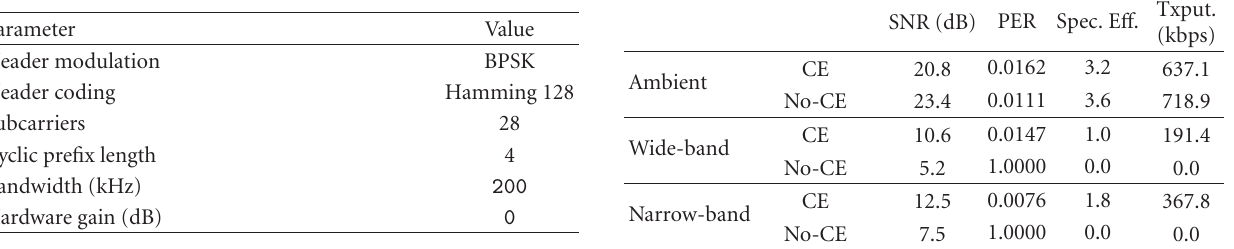
Table 5: Static parameters within the transmission.